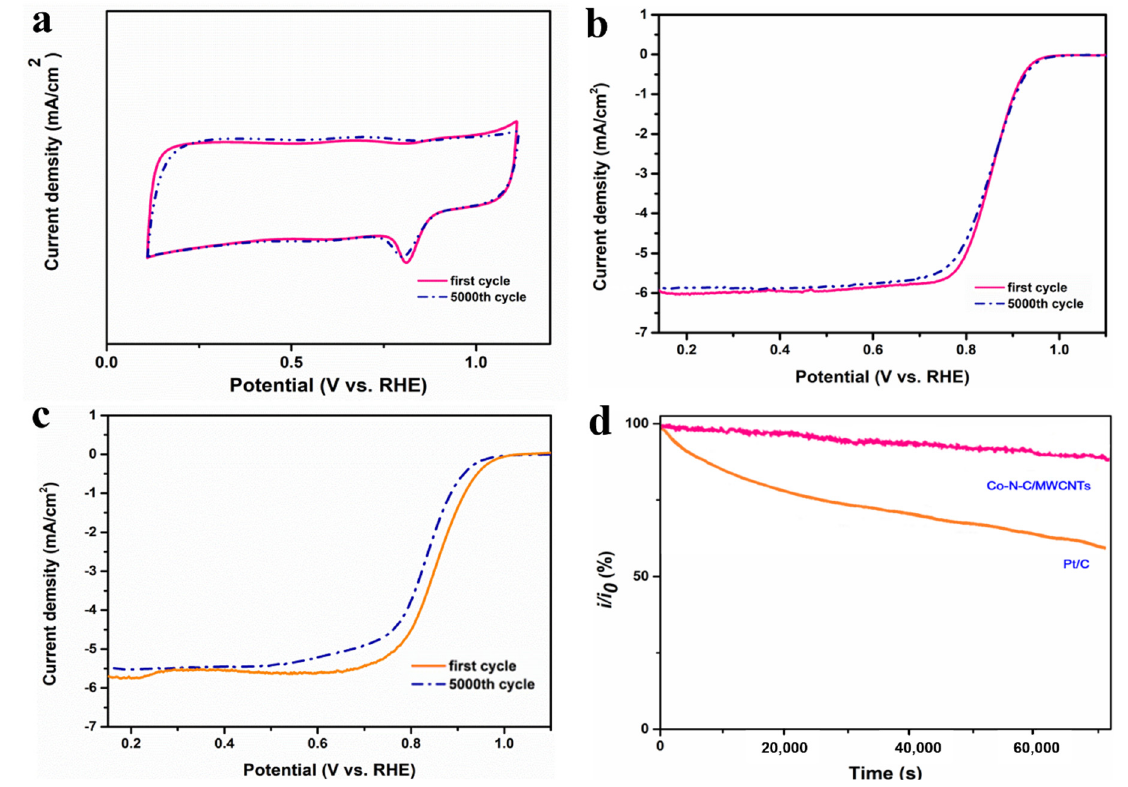
Figure 6. ( a , b ) CV and LSV curves of gl-CNTs/Co@N-C before and after 5000 cycles; ( c ) LSV curves of Pt/C before and after 5000 cycles; ( d ) Chronoamperometric responses within gl-CNTs/Co@N-C and Pt/C catalysts.